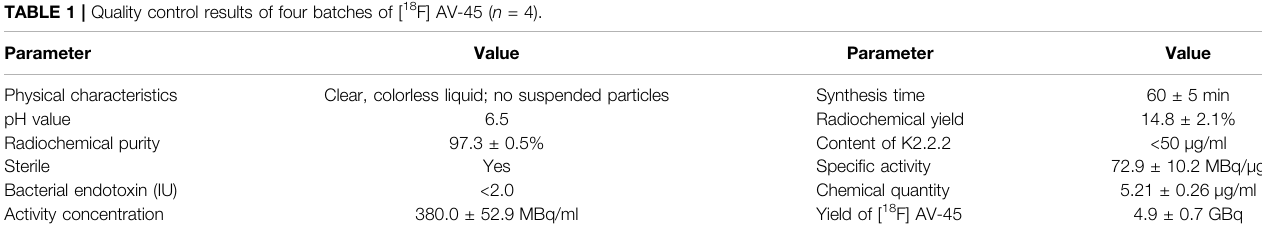
TABLE 1 | Quality control results of four batches of [ 18 F] AV-45 ( n = 4).